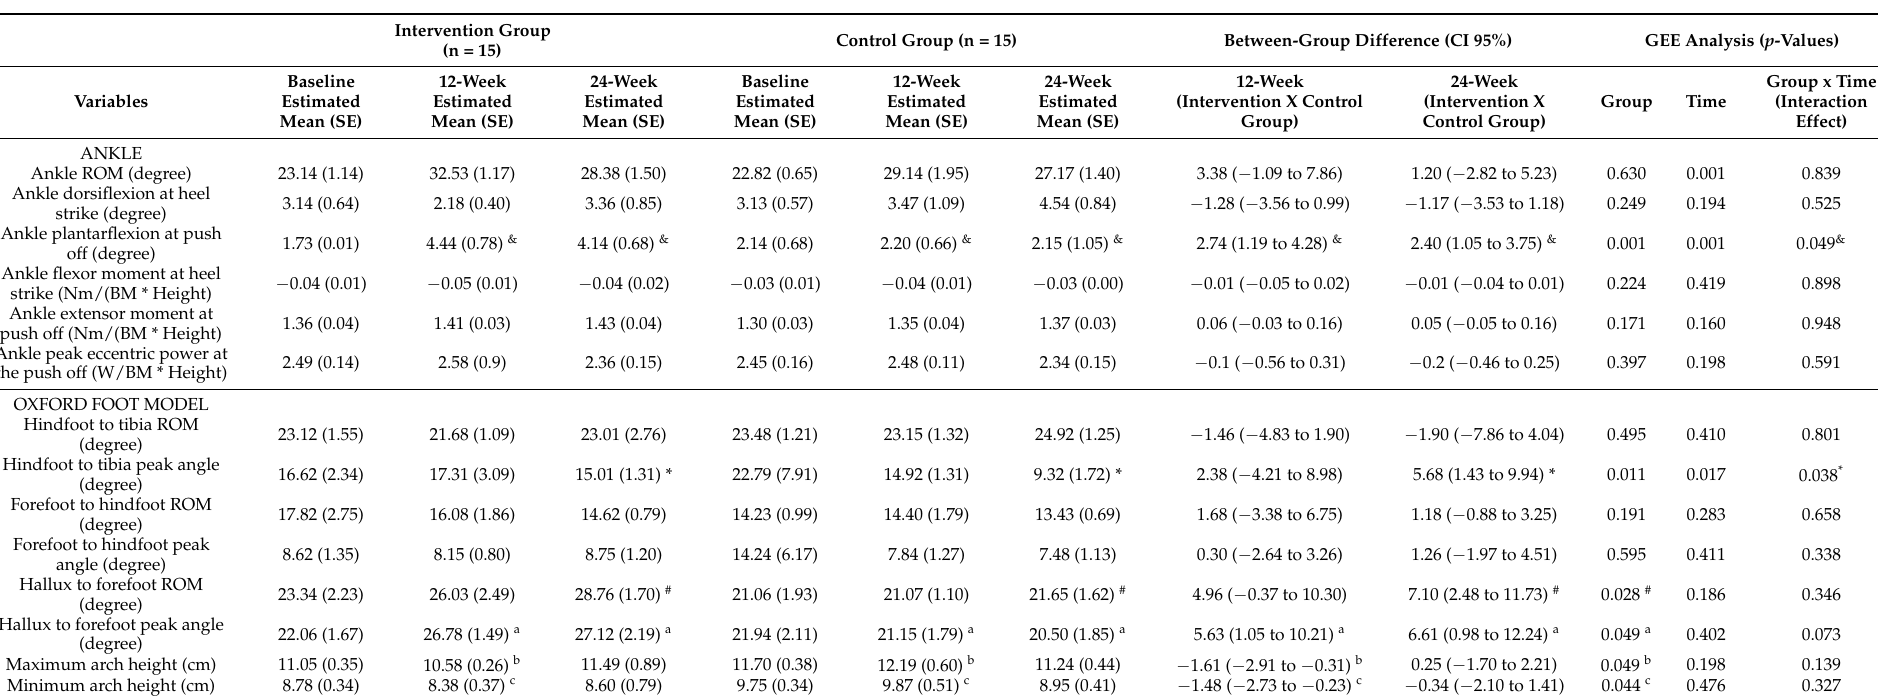
Table 4. Estimated mean (standard error; SE), p-values from Generalized Estimating Equation (GEE), and between-group mean difference at 12 and 24 weeks (95% confidence interval) of the foot–ankle kinematics and ankle joint kinetics during gait for the control and intervention